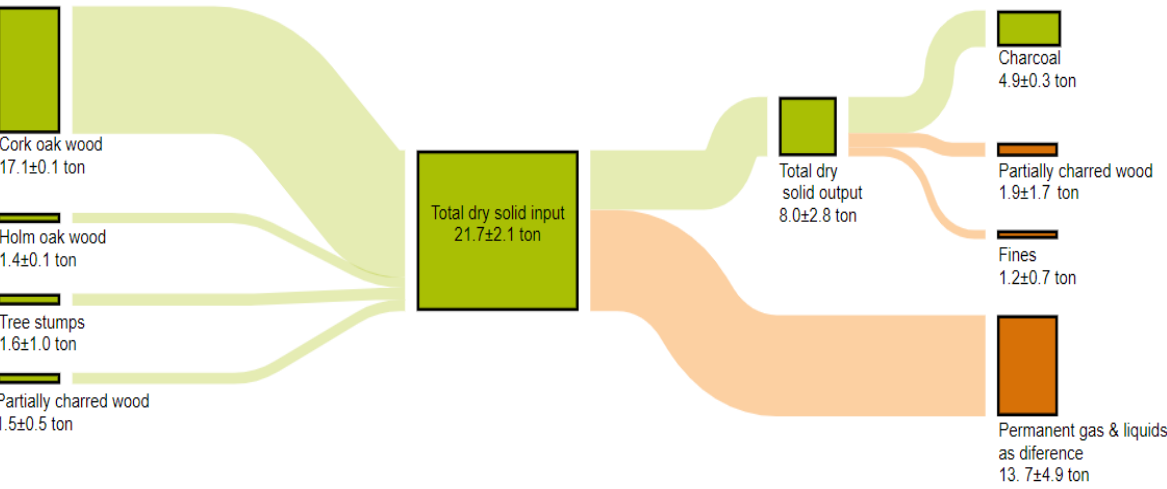
Figure 7. Mass balance to the carbonization process based on the results from both Test 1 and Test 2. The masses of solid inputs and outputs are dry masses, which means that the permanent gases and liquids taken as differences only account for those released from the dry wood charge.